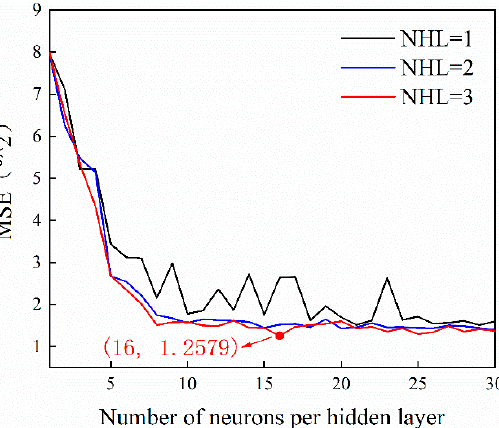
Figure 4. Results for MSE after 10 training runs as a function of hidden layers and neurons per layer.